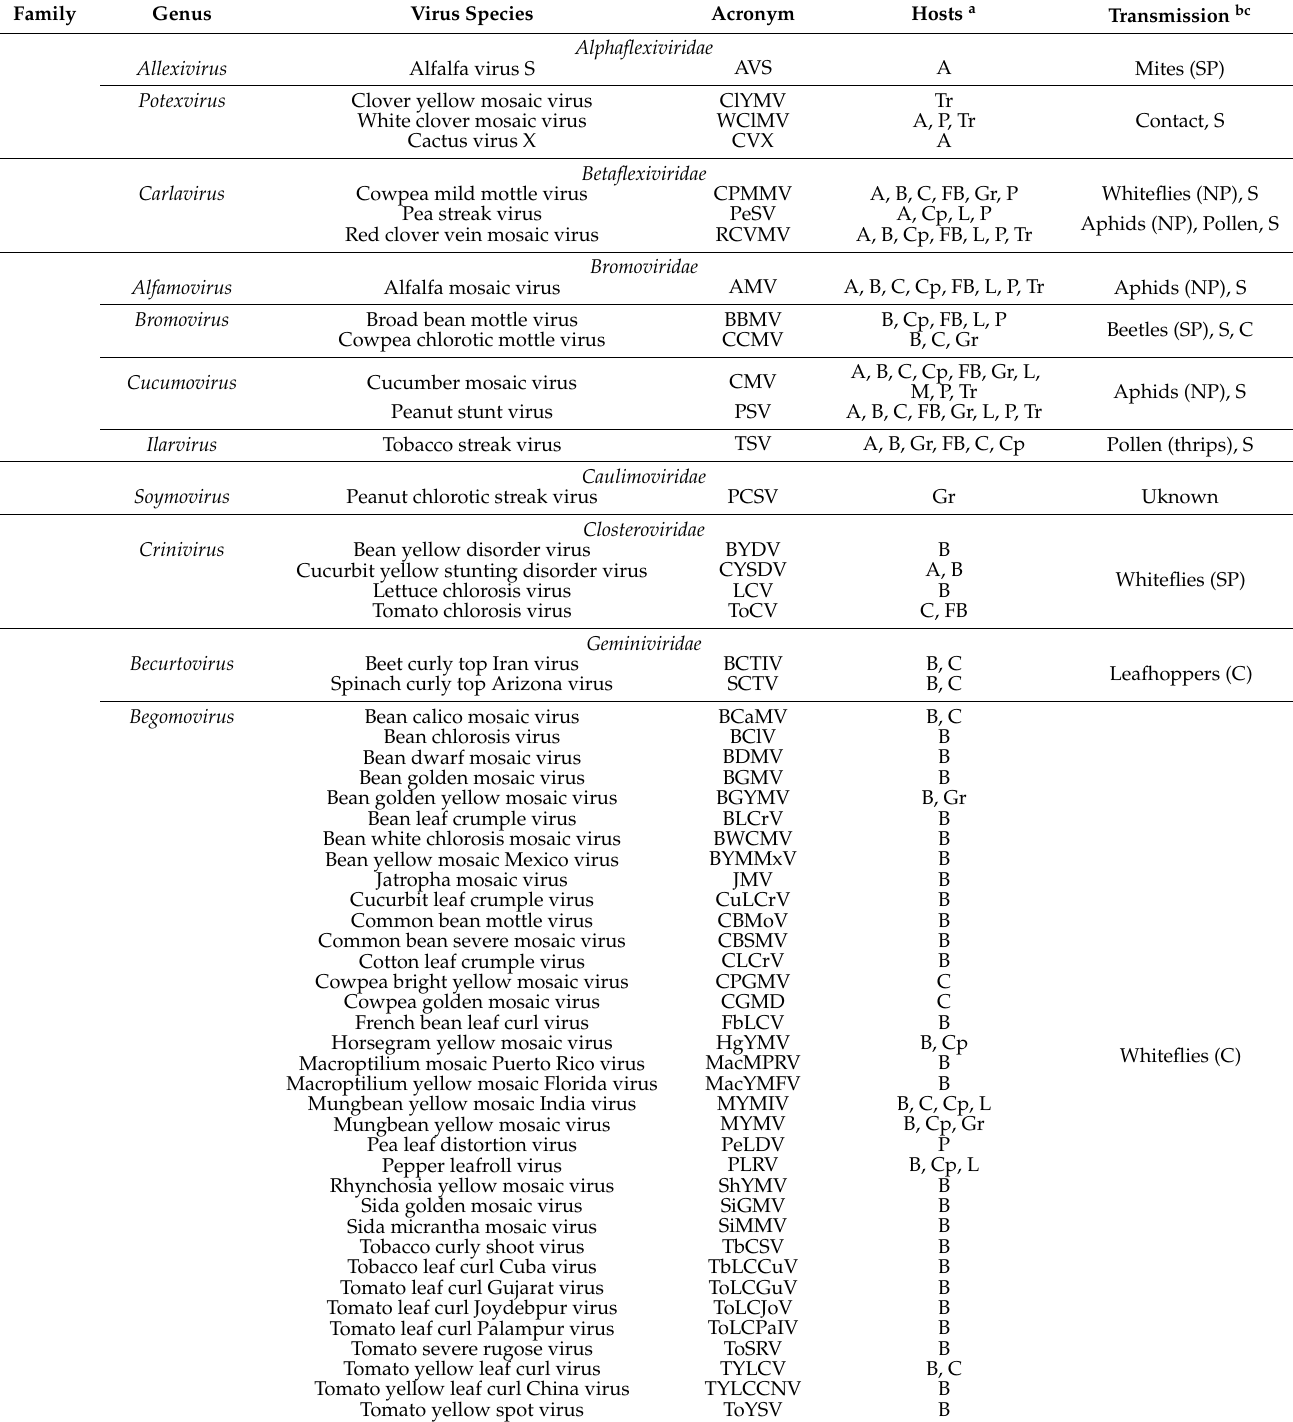
Table 1. The family-level classification of the legume-infecting viruses (according to the International Committee on Taxonomy of Viruses, ICTV Master Species List 2020.v1, [10]), hosts and transmission.